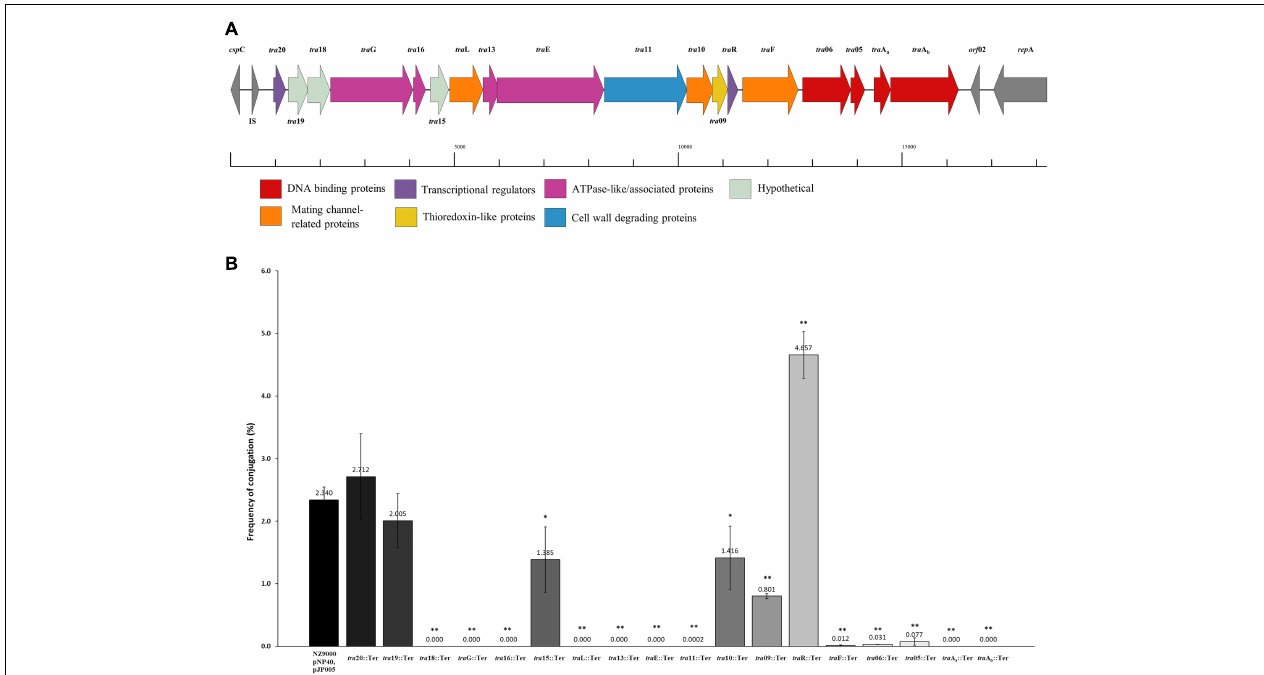
FIGURE 3 | Functional and mutational analysis of the pNP40 conjugation cluster. (A) pNP40 conjugation cluster, showing the organization of the 19 genes that compose it and their assigned functions. (B) Conjugation frequencies after mutating each individual gene from the pNP40 conjugation cluster. All conjugations were done using as donor the recombinant strain (NZ9000 pNP40, pJP005, and with the individual mutation) and MG1614 as the recipient. Conjugation between a wild-type donor and MG1614 was used as a control. A p-value < 0.05 was considered significant and is represented with a single asterisk “ ∗ ”, while a p-value ≤ 0.001 was considered very significant and is represented by two asterisks “ ∗∗ ”. Data are the mean of three replicates ± standard deviation.